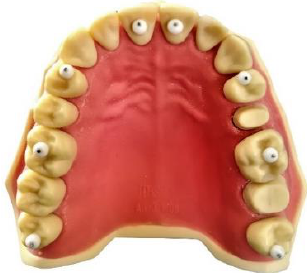
Figure 1. Master model .